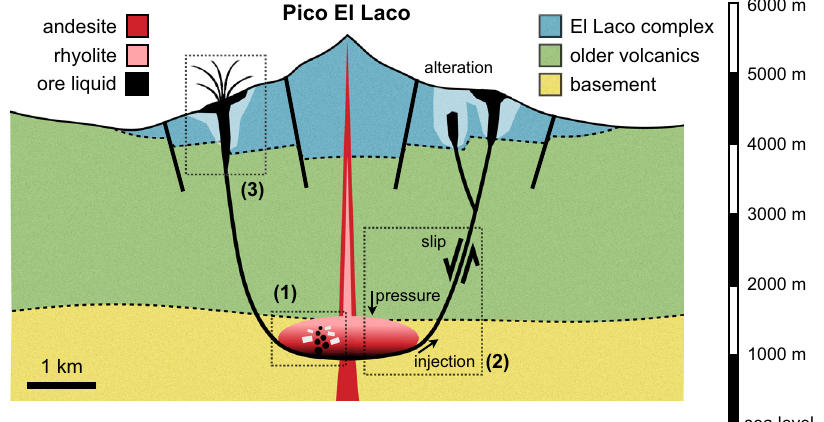
Fig.6|Geneticmodelofmagnetite-apatitedepositsatElLaco. (1)exsolutionandgravitationalseparationofimmiscibleFe-P-richmelt,(2)drivenintocollapsefractures during slip events, and (3) extruded by volume-generating feedback of vapour exsolution and bubble expansion upon